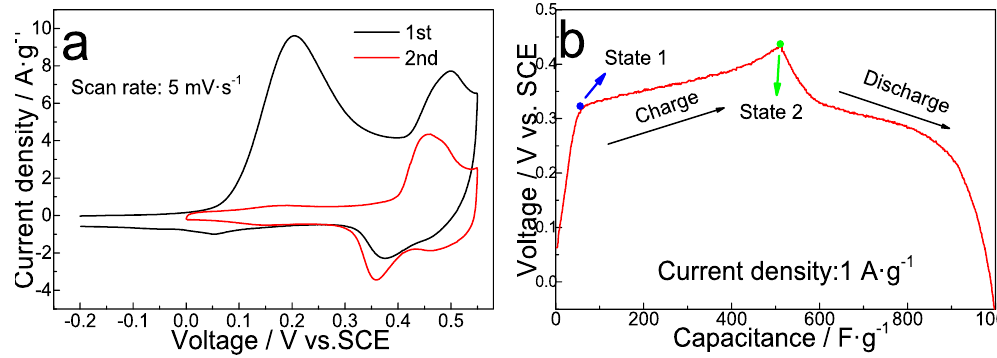
Figure 3. ( a ) CV curves and ( b ) charge-discharge curves of ME-CoCO 3 .